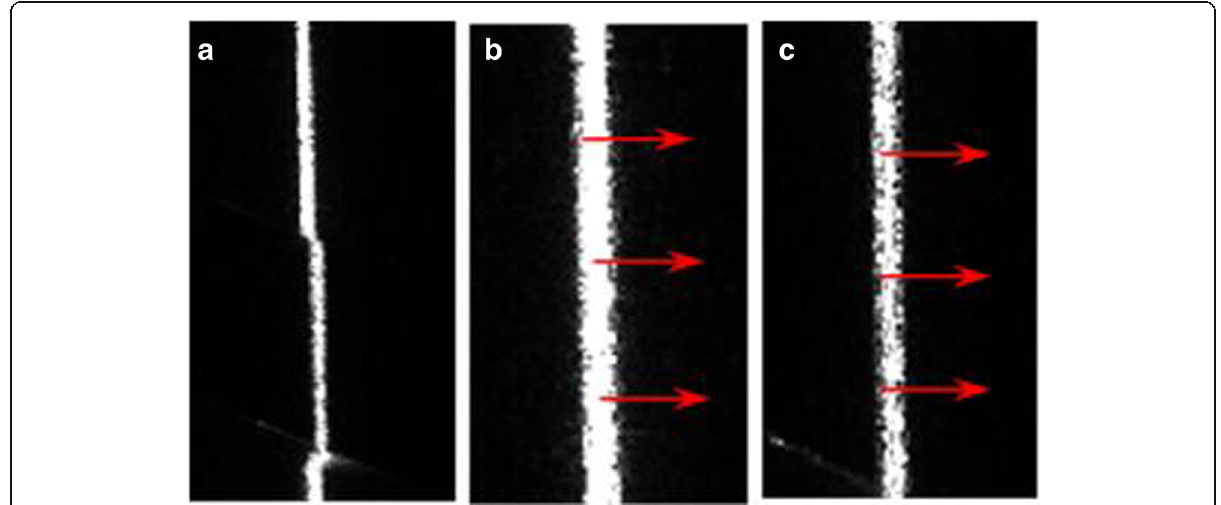
Fig. 3 The grayscale image of linear light stripe. a The image of target b The image of stripe on the paper plane c The image of stripe on the gauge